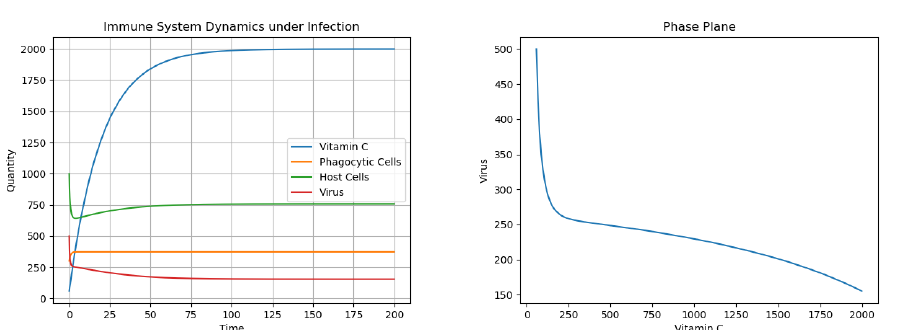
Figure 10. Dynamics under CGD with Extreme Constant Infusion of Vitamin